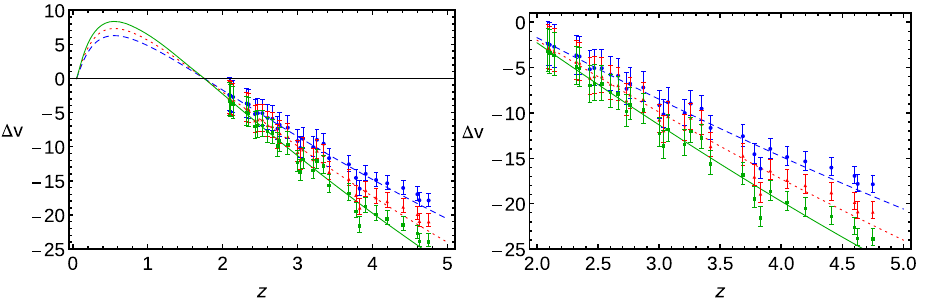
Fig. 2 Datasets for SL test based on F fit ( z ; b , c , d , e ) for different observation periods: blue (circle and dashed line) for 24 years, red (triangle and dotted line) for 28 years and green (square and solid line) for 32